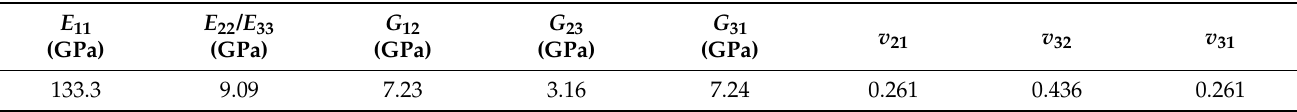
Table 1. Mechanical properties of orthotropic